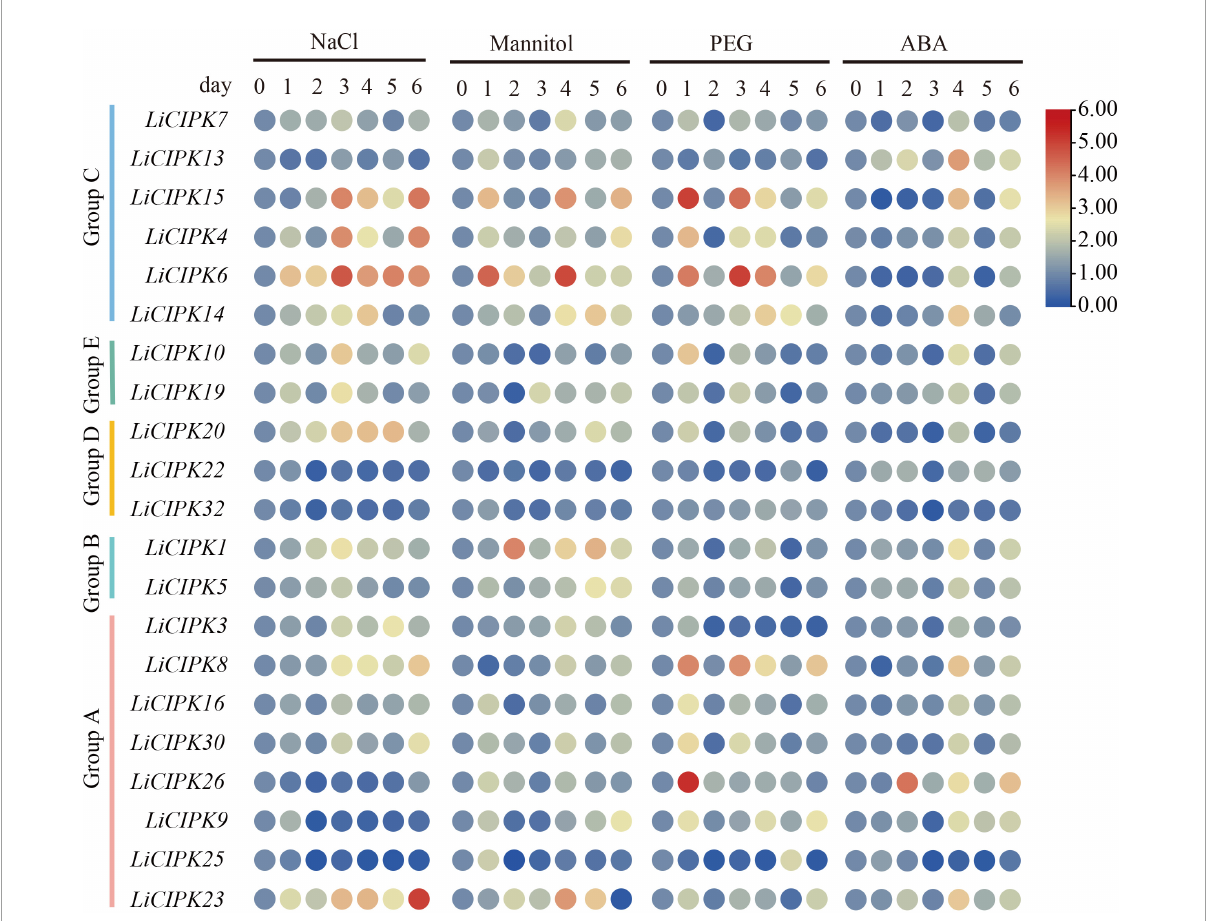
FIGURE6 Expression profiles of LiCIPKs under four kinds of abiotic stress. Cuttings were treated by NaCl solution (200 mmol · L − 1 ), mannitol solutions (200 mmol · L − 1 ), 15% PEG8000 and ABA (10 × 10 − 4 mol · L − 1 ), respectively. Roots were collected after treatment of 0, 1, 2, 3, 4, 5, and 6 days. The mean fold changes of the expression level are depicted by heat map. n ≥